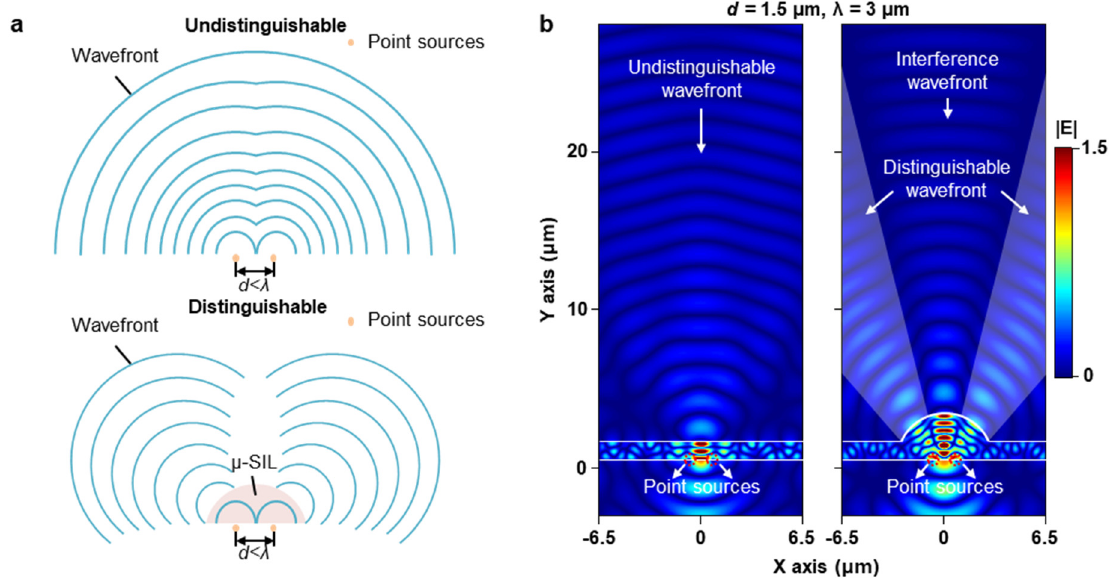
Figure 6. ( a ) Schematic illustration for super-resolution imaging by silicon µ-SIL. Without the silicon µ-SIL, closely-located two point sources ( d < λ) are undistinguishable owing to the diffraction limit. However, the silicon µ-SIL can overcome the diffraction limit. ( b ) Electric field simulations using two point sources at d = 1.5 µm (left) without and (right) with the silicon µ-SIL.